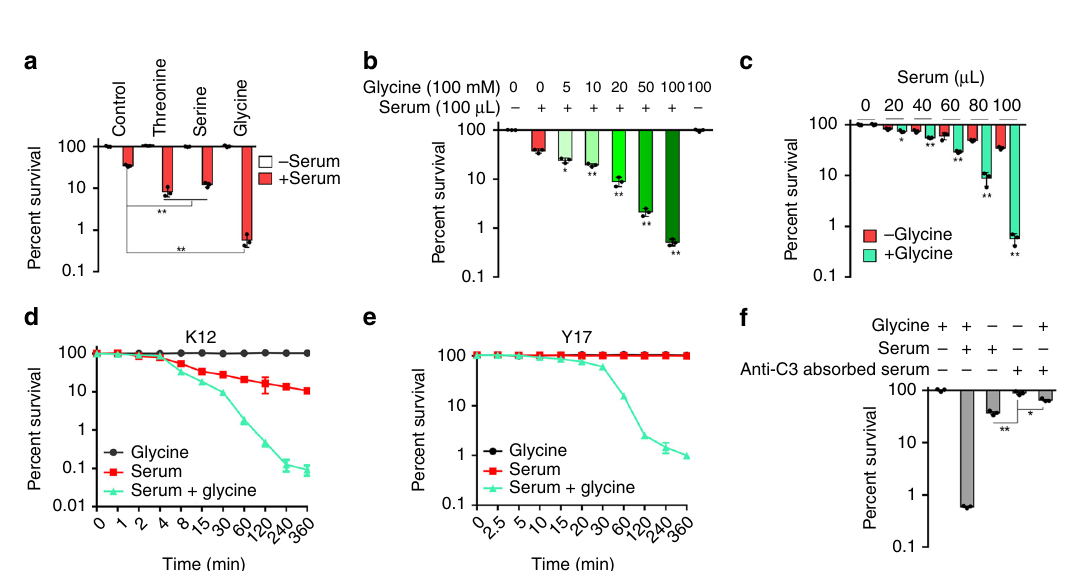
Fig. 2 Glycine increases the susceptibility of E. coli to serum. a Percent survival of E. coli K12 incubated with 100 μ L serum in the presence or absence of 100 mM glycine, serine, or threonine ( n = 3). b Synergetic effects of 100 μ L serum and glycine on viability of E. coli K12 were measured in a glycine dose- dependent manner (0 – 100 mM) ( n = 3). c Percent survival of E. coli K12 incubated with 100 mM glycine plus serum (0 – 100 μ L) or without glycine ( n = 3). d , e Percent survival of E. coli K12 ( d ) and Y17 ( e ) in the presence of 100 mM glycine or/and 100 μ L serum for the indicated length of time ( n = 3). f Percent survival of E. coli K12 in the presence of 100 mM glycine or/and 100 μ L serum or anti-C3 absorbed serum for 2 h ( n = 3). Results are displayed as mean ± SEM ( a – f ), and signi fi cant differences are identi fi ed (* p < 0.05, ** p < 0.01) as determined by two-tailed Student ’ s t test ( a – c , f ). See also